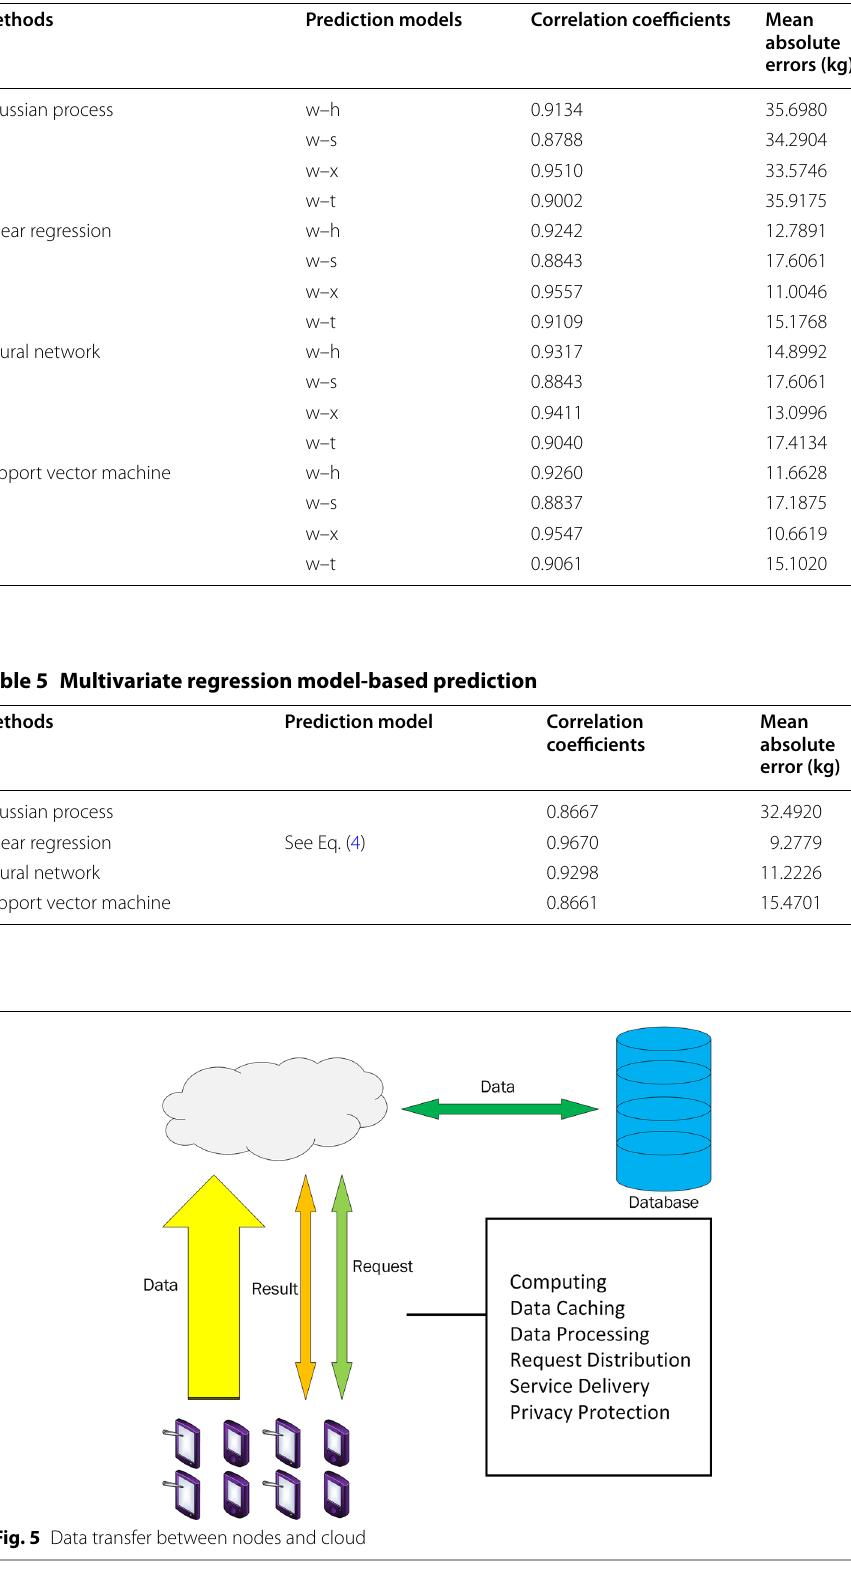
Table 4 Univariate regression model-based prediction